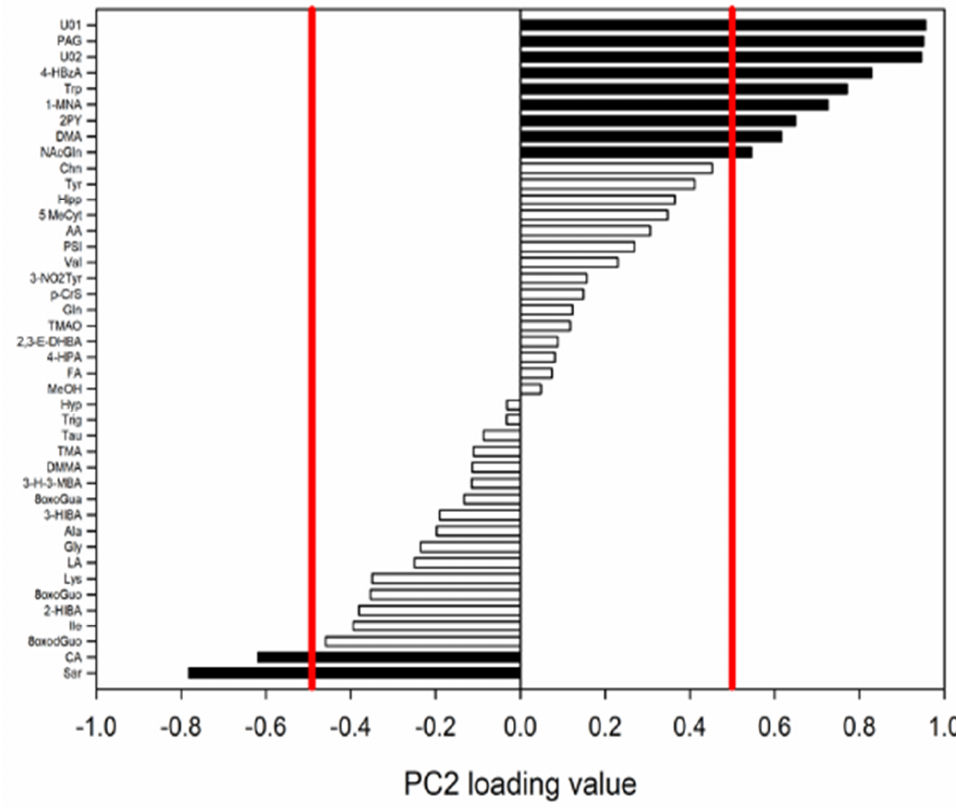
Figure 4. The PCA normalized loading values for PC2. Values greater than 0.514 and lower than − 0.514 (red bars) were considered significant for the model ( p < 0.05).